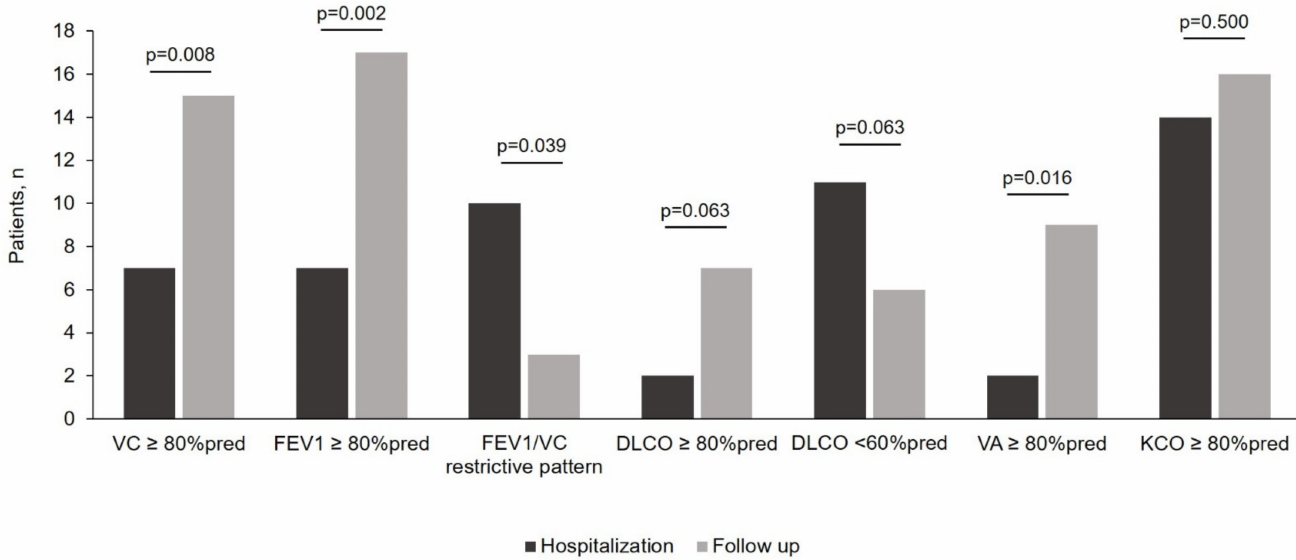
Figure 2. Change in the proportion of patients with lung function alterations during hospitalization (dark grey columns) and at the follow up visit (light gray columns-6 weeks post-discharge). Restrictive pattern was considered the combination of a FEV 1 /VC ≥ 100% predicted and a concomitant FEV 1 and VC < 80% predicted. DLco: lung diffusion capacity for carbon monoxide; FEV 1 = forced expiratory volume in one second; KCO = transfer factor for carbon monoxide; VA = alveolar volume; VC = vital